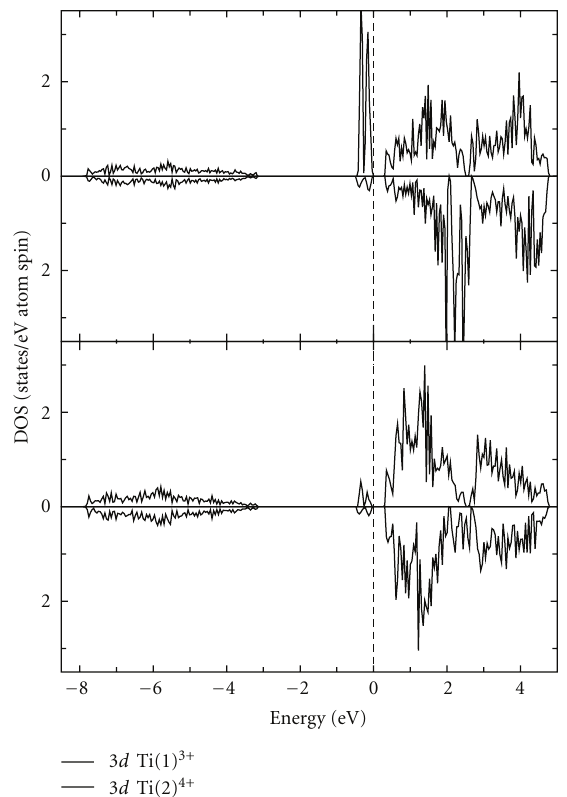
Figure 23: The partial DOSs for Ti(1) 3+ and Ti(2) 4+ cations are shown [187]. The gap value of 0.29 eV was obtained by LSDA+ U with U = 3 . 0 eV and J = 0 . 8 eV. The Fermi level is shown by dotted line.